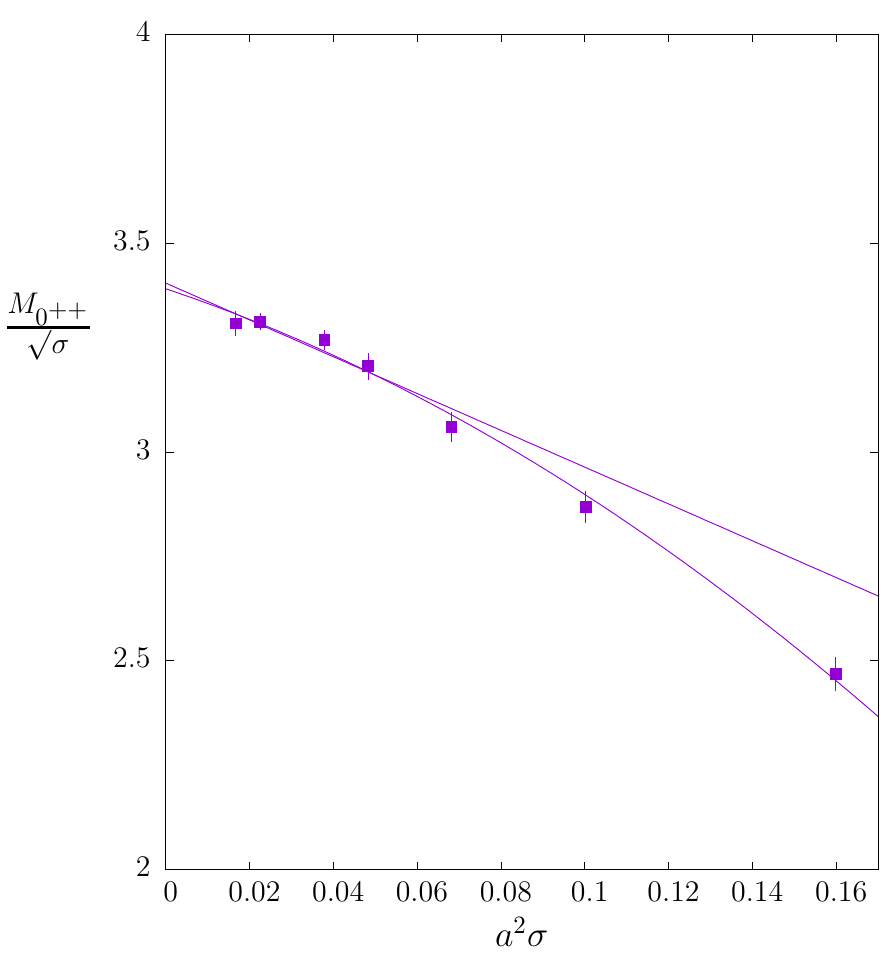
Figure 11 . The lightest J PC = 0 ++ glueball with linear and quadratic extrapolations to the continuum